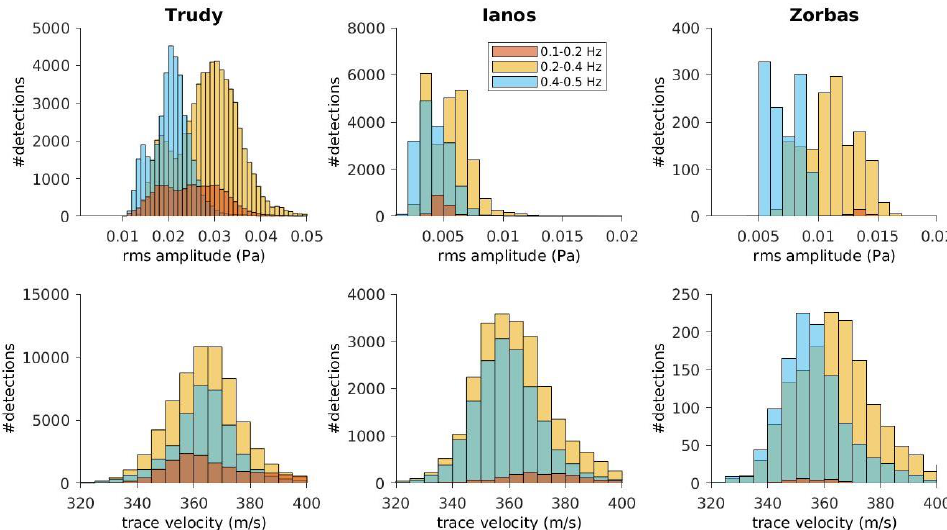
Figure 9. Distributions of rms amplitudes ( top ) and trace velocities ( bottom ) for detections related to Trudy ( left ), Ianos ( middle ), and Zorbas ( right ) in the microbarom frequency range. Red color relates to the 0.1–0.2 Hz range, yellow to the 0.2–0.4 Hz range, and blue to the 0.4–0.5 Hz range. Where blue bars are superimposed to yellow bars the transparency leads to the green color. Transparency also darkens the red color. ( “#detections” means “number of infrasound detections” ).